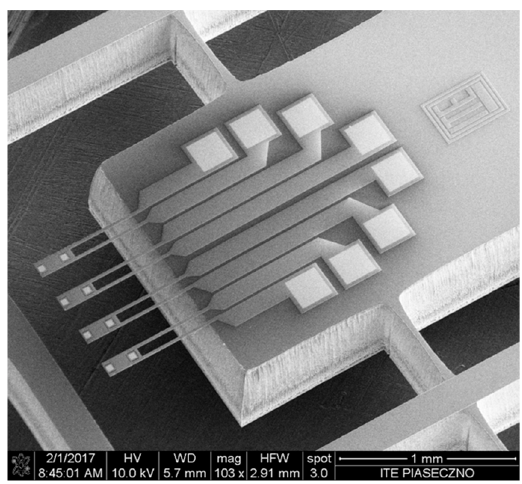
Figure 3. The scanning electron microscope (SEM) image of the final structure. Scanning parameters of the image. High Voltage (HV) = 10 kV; Working Distance (WD) = 5.7 mm; Horizontal Field of View (HFW) = 2.91 mm.